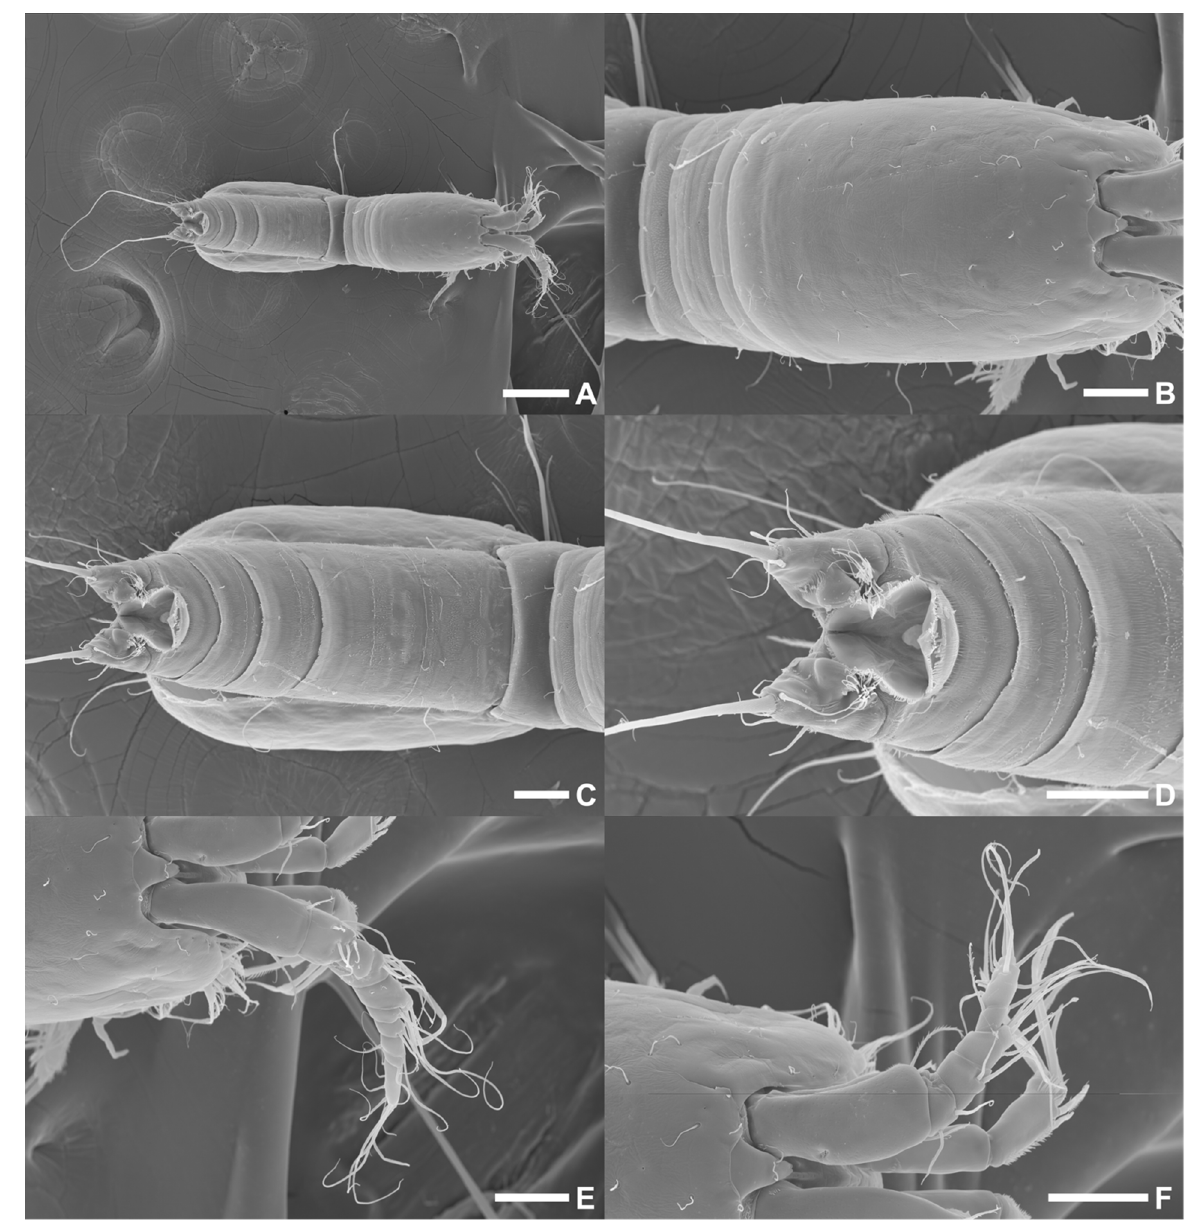
Figure 21. Scanning electron microscopy images of Phyllopodopsyllus similis sp. nov. female (paratype 2) in dorsal view: ( A ) habitus; ( B ) prosome; ( C ) urosome; ( D ) anal somite and caudal rami; ( E ) antennule; ( F ) atypical antennule. Scale bars: ( A ) 100 µm; ( B – F ) 30 µm. Labrum (Figures 24C, S8C, S9C, S10C, and S11B) well-developed, gradually tapering ventrally, decorated with patch of long setules along posterior margin distally, and covered with long and slender setules throughout cutting edge; anterior and lateral surfaces dimpled Mandible (Figures 24C, 28A, S10C, and S11B) composed of coxa, basis, one-segmented endopod, and one-segmented exopod. Coxa enlarged and with gnathobase bearing pinnate dorsal seta and row of multicuspidate teeth. Basis gradually widening distally, pentagonal, shorter than coxa, furnished with longitudinal rows of long spinules on anterior surface, and armed with three pinnate setae originating from terminal margin. Endopod much shorter than basis and armed with two lateral setae and six apical bare setae. Exopod slightly narrower than endopod, about as long as endopod, and with five setae (three lateral